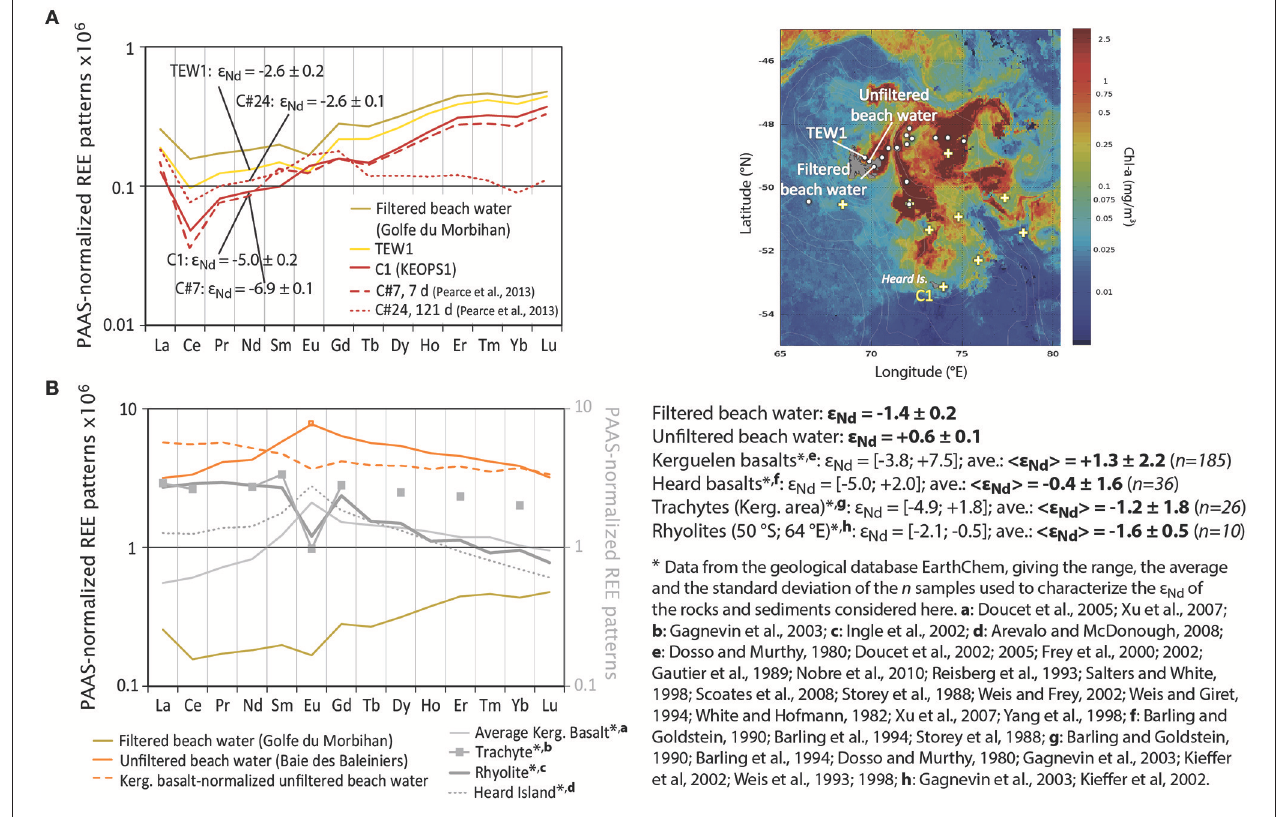
FIGURE 7 | (A) PAAS-normalized REE patterns and ε Nd of the dissolved fraction of the TEW1 coastal sample and of a beach water sample collected during the KEOPS2 cruise in the Golfe du Morbihan, W-SW of station G2. For the readability of the Figure, G2 is not reported here, as it is similar to TEW1. The pattern of the Heard Island coastal water (station C1, Zhang et al., 2008) is also reported here, for comparison. We also reported the PAAS-normalized REE patterns obtained 7 days (C#7) and 121 days (C#24) after the beginning of an experiment performed by Pearce et al. (2013) that investigated the dissolution of marine sediments taken from a core top collected at C1 during the KEOPS1 cruise. (B) PAAS-normalized REE patterns and ε Nd of the sediments and rocks characterizing the Kerguelen Plateau area (average patterns of the Kerguelen and Heard basalts and of the trachytes and rhyolites of the area, from the geological database EarthChem www. earthchem.org; right gray scale). We also added the REE patterns and ε Nd of TEW1 and of an unfiltered beach water sample collected in the Baie des Baleiniers, close to TEW1 (S-SE of it; left black scale). The dashed orange pattern results from the normalization of the unfiltered beach water REE concentrations to the averaged REE concentrations of the Kerguelen